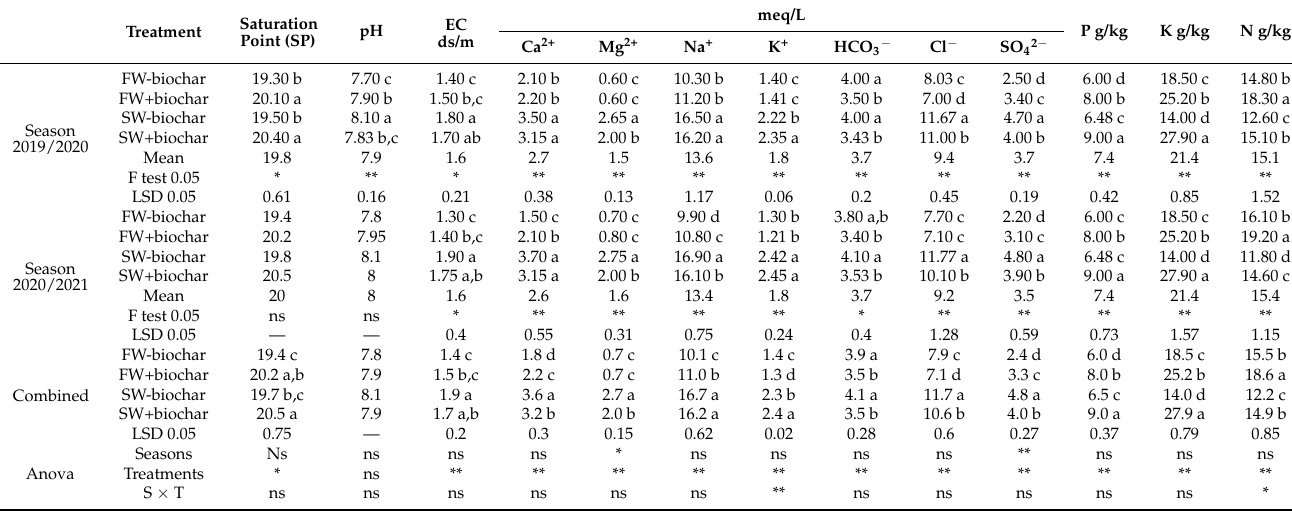
Table 4. Soil analysis after 70 days of biochar addition.